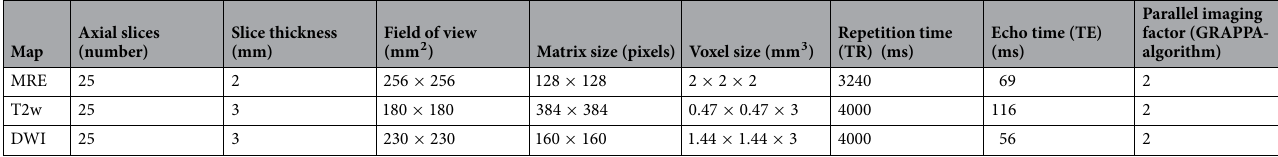
Table 1. Imaging parameters of MRE and